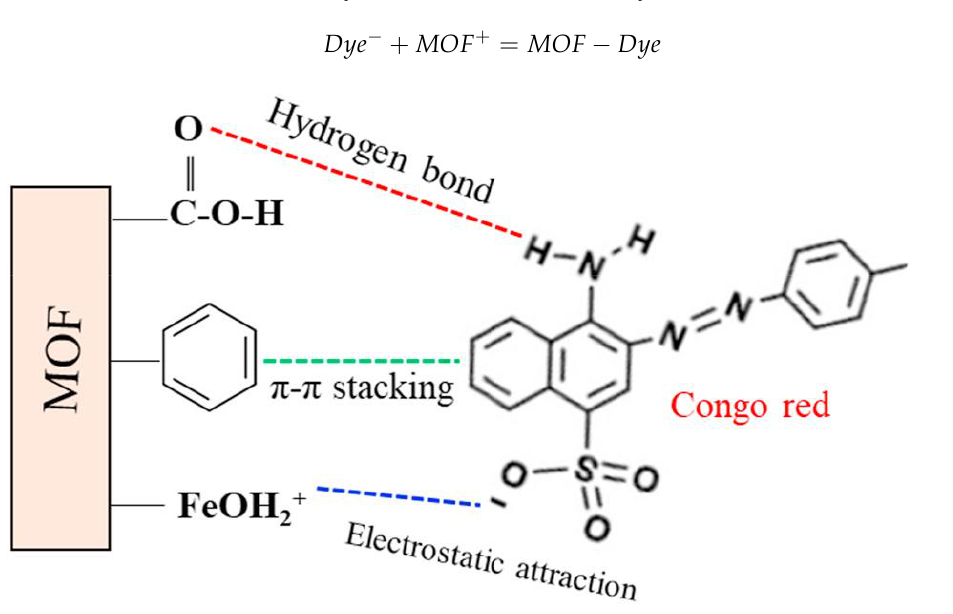
Figure 7. Various interactions of dye molecules during adsorption over MOFs. Reprinted from ref. [108] with permission. Table 4. Different MOFs were reported for the adsorption of various water-soluble dyes. MOFs